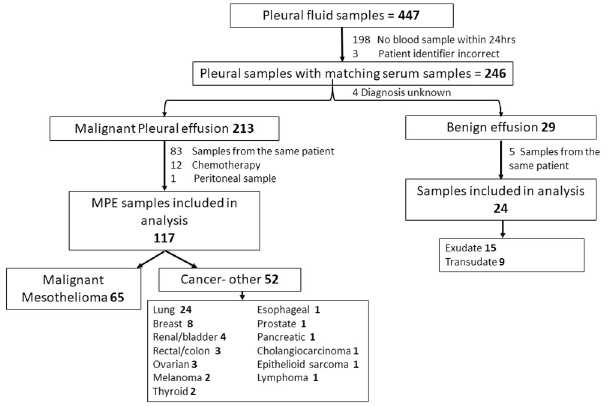
Fig 1. Flow diagram of samples included in